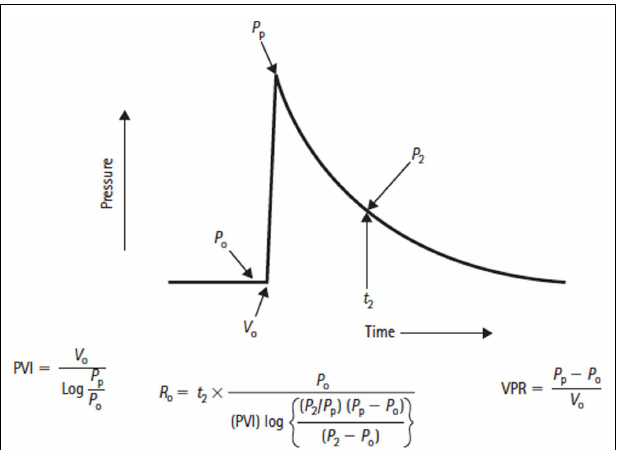
FIGURE 4 | Formulas for deriving the pressure–volume index (PVI), volume–pressure response (VPR), and the CSF outflow resistance ( R o ), where P 0 is the baseline CSF pressure, P p is the peak pressure resulting from a bolus volume injection V 0 , and P 2 refers to the pressure point on the return trajectory at time t 2